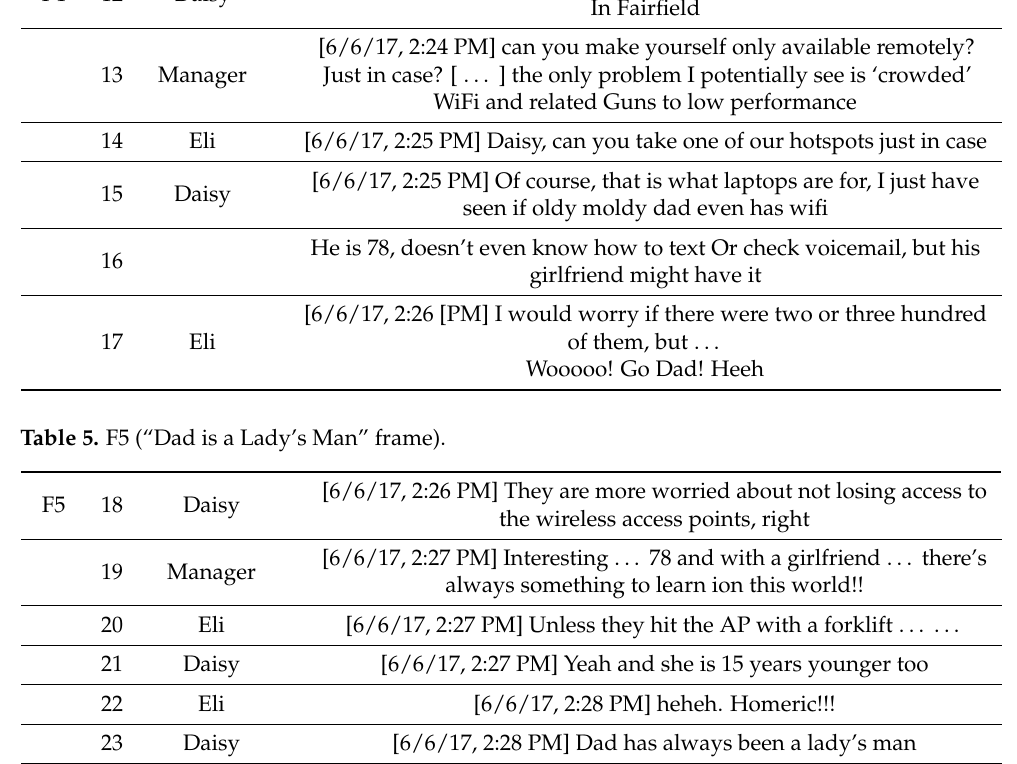
Table 4. F4 (“Daisy Goes to Visit Her Dad” frame). F4